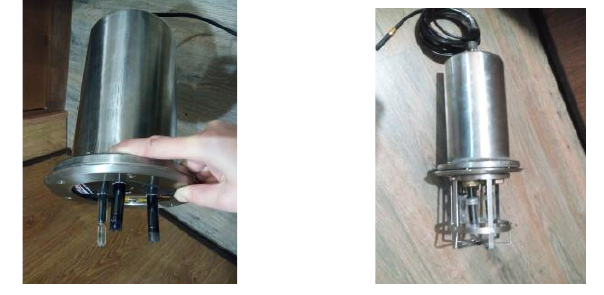
Figure 6. The construction of the IoT